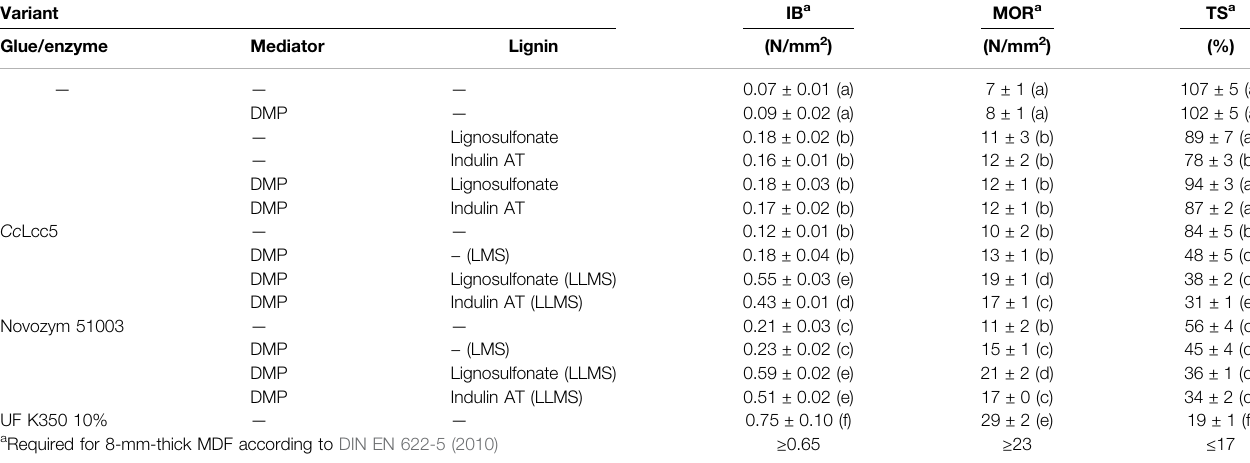
TABLE 2 | Physical – mechanical properties for 8-mm-thick MDF and a density of 780 kg/m 3 bonded with laccases, LMS, and LLMS. Variant IB a